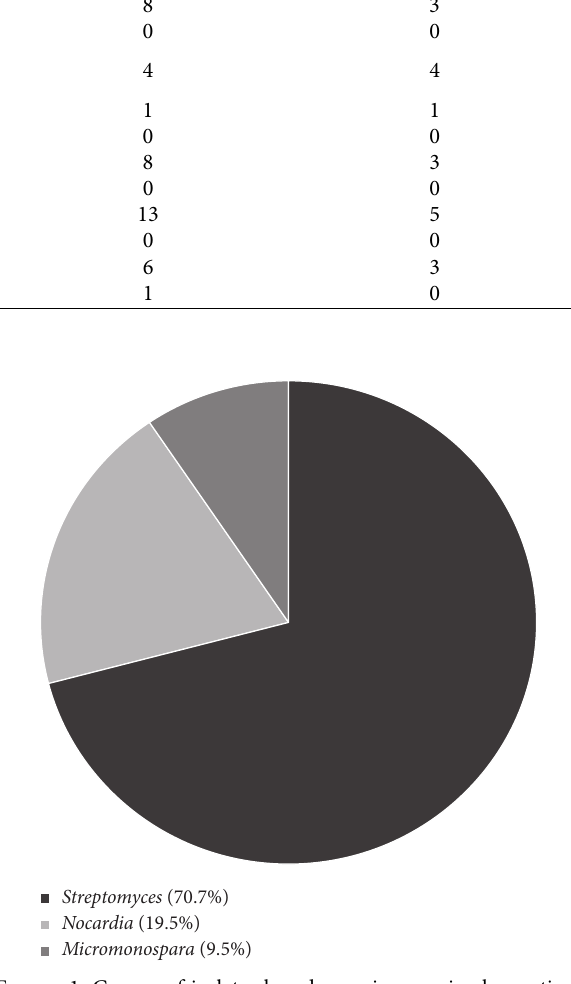
Figure 1: Genera of isolates based on microscopic